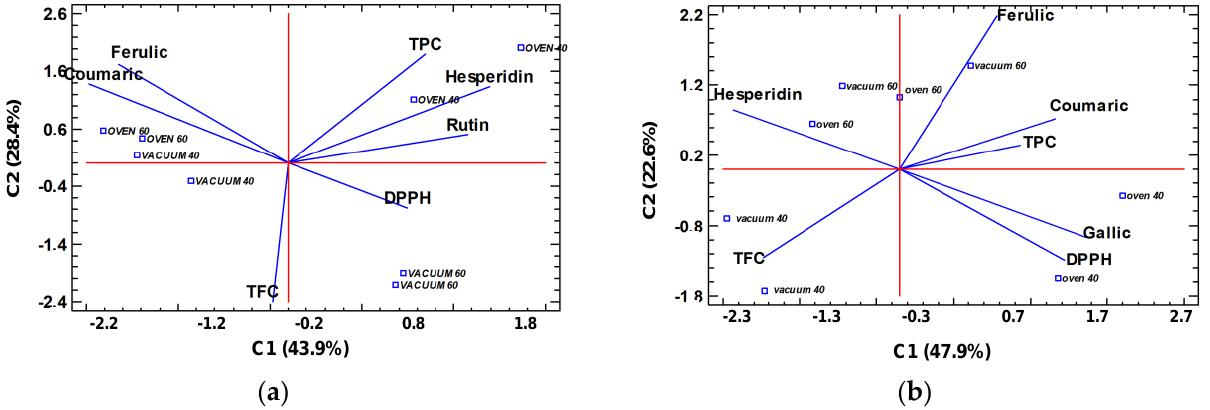
Figure 4. Principal component analysis biplot of the simultaneous evaluation of the loadings (individ- ual phenolic concentration, TPC, TFC and DPPH) and scores (drying treatments) studied in: ( a ) lemon peel extracts and ( b ) clementine peel